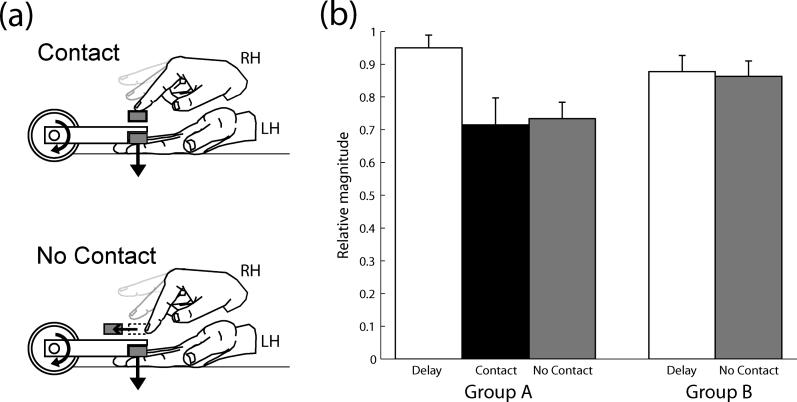
Experimental Task and Results(A) Schematic of the apparatus and task. On contact trials (top), in response to an auditory go signal, participants produced a brief force pulse with their right index finger on a force sensor fixed above their left index finger. A similar force pulse was delivered to the left index finger by a torque motor. On no-contact trials (bottom), the force sensor was moved at the start of the trial so that participants made a tapping movement with their right index finger but did not make contact.(B) Mean relative magnitude of the comparison tap to the test tap at the point of perceptual equality as a function of trial type and participant group. Error bars represent ±1 SE.